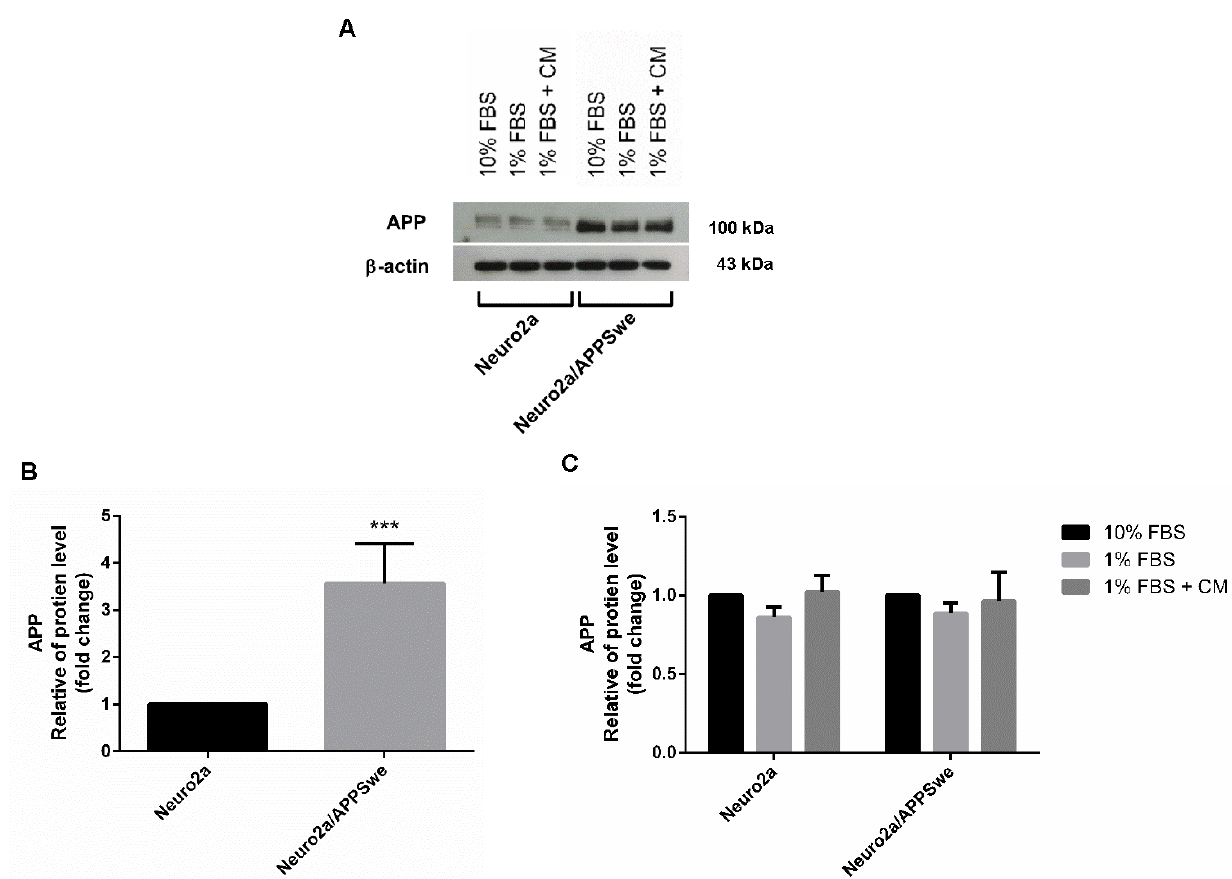
Figure 4. APP expression level. ( A ) Western blot analysis revealed that APP expression in Neuro2a/APPSwe cells was higher than that in Neuro2a cells. ( B ) In 1% FBS medium, APP was significantly different between wild-type cells and APPSwe-overexpressing Neuro2a cells ( C ) The APP levels between treatment groups of Neuro2a and Neuro2a/APPSwe cells were normalized vs. the 10% FBS group for each cell type. The analysis showed that Neuro2a/APPSwe cells exhibited higher levels of APP than Neuro2a cells. APP level in both cells did not differ in 10% FBS, 1% FBS, and 10 µg/mL CM extract in 1% FBS treatment. Values are mean ± SD of at least three independent experiments. *** p -value < 0.001.